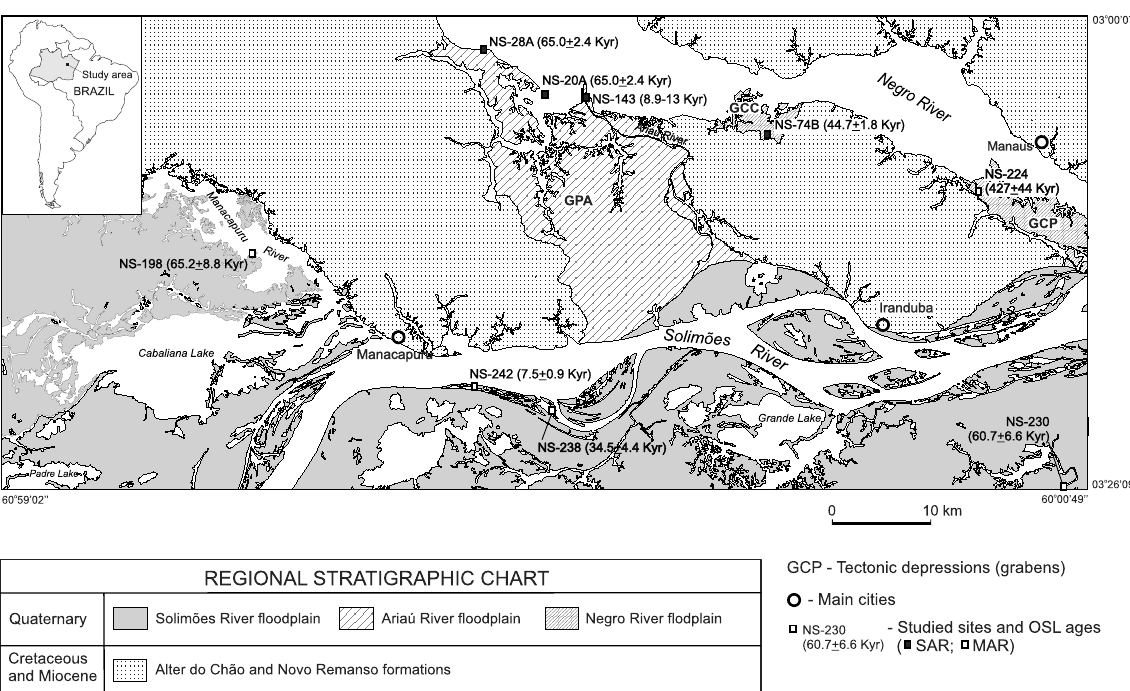
Fig. 1 – Geological setting and location of studied